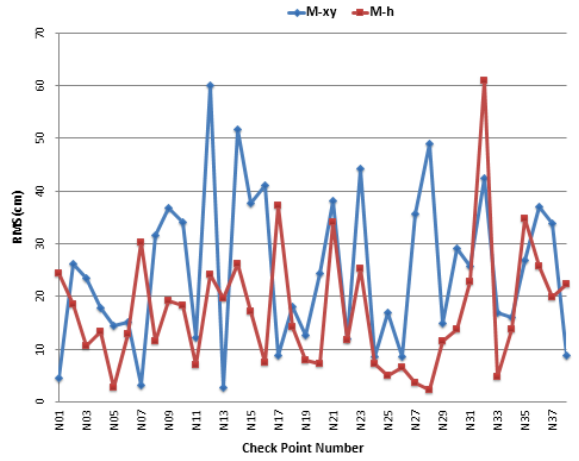
Figure 8. Positioning accuracy analysis of power-line inspection LIDAR